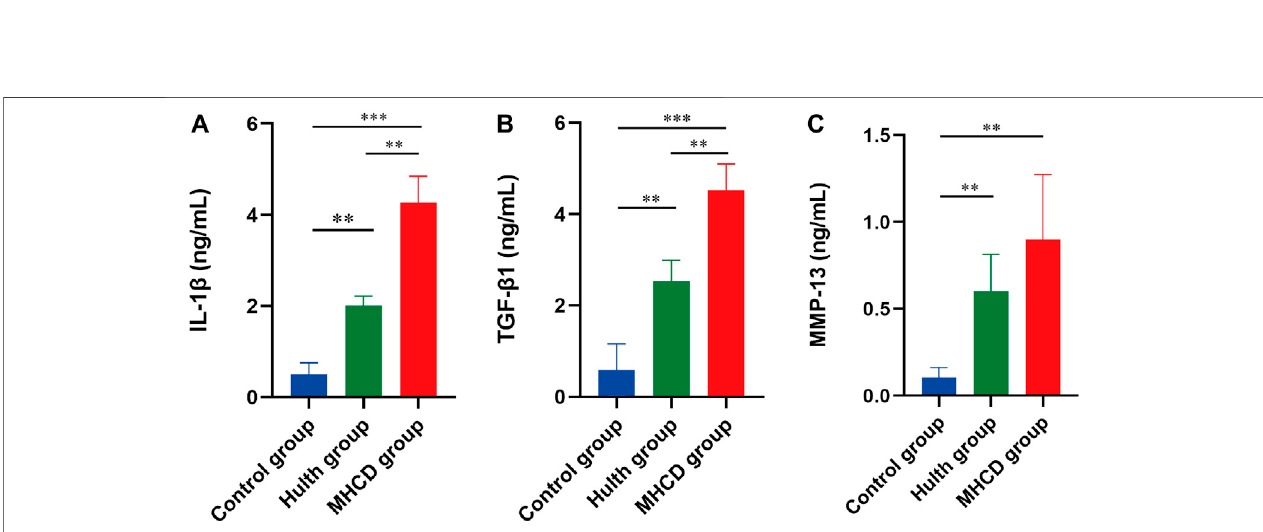
FIGURE 9 | Concentrations of three representative proteins in the synovial fl uid of rhesus macaques on Day 120. Concentrations of (A) IL-1 β , (B) TGF- β 1, and (C) MMP-13 were measured by ELISA. IL-1 β , interleukin-1 β ; TGF- β 1, transforming growth factor- β 1; MMP-13, matrix metalloproteinase-13. * p < 0.05, ** p < 0.01, *** p < 0.001. Data are presented as the mean ±